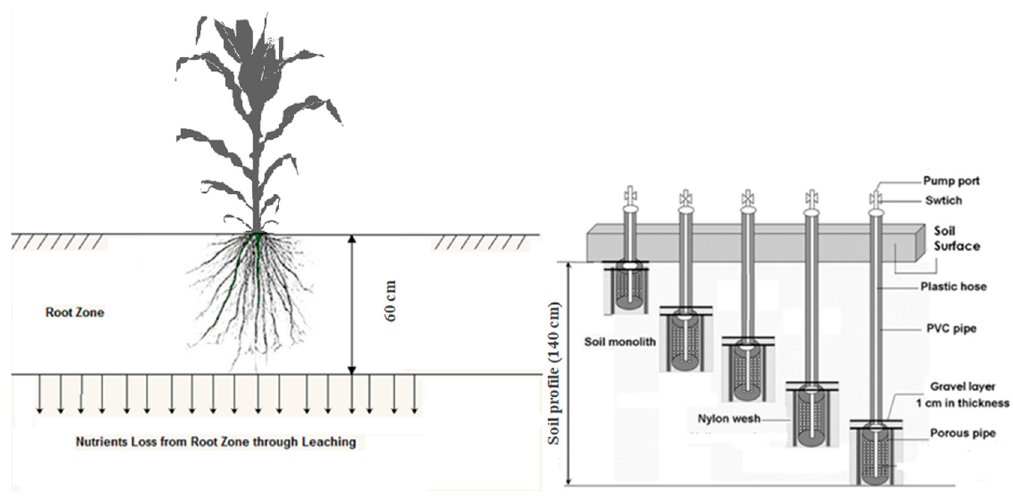
Figure 4. The layout of soil water samplers installed at 20, 40, 60, 80, and 140 cm depth. The nutrient losses were calculated from the equation given as